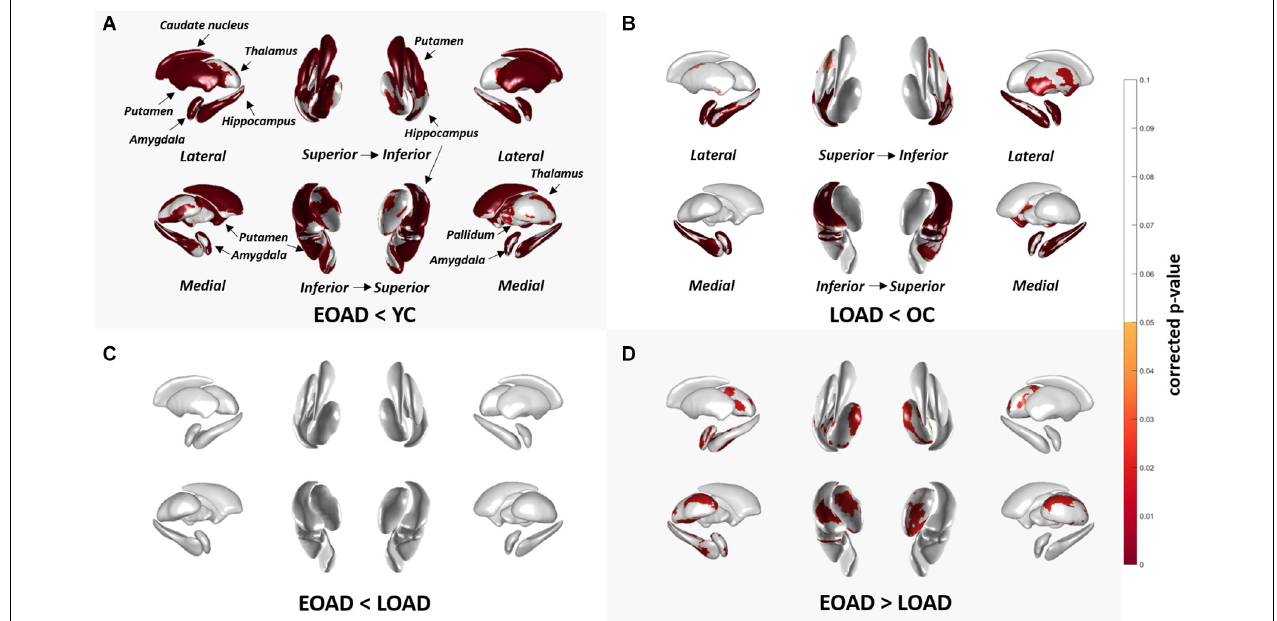
FIGURE 1 | Group comparison of shape of subcortical structures. (A,B) Group-wise comparison of the subcortical local shape adjusted with age, sex, education, ICV; (C,D) sex, education, ICV was adjusted. Corrected p -values after FDR multiple correction for each 12 structures (left and right amygdala, hippocampus, caudate, pallidum, putamen, and thalamus) were mapped. Abbreviations: EOAD, early-onset Alzheimer’s disease; LOAD, late-onset Alzheimer’s disease; YC, young control; OC, old control.